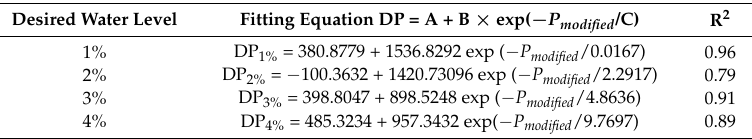
Table 2. Fitting equations between the modified system poles and DP